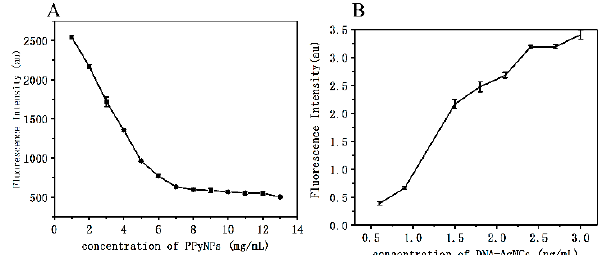
Figure 5. ( A ) The FI of C6G5C6-apt-AgNCs in the presence of various concentrations of PPyNPs (1, 2, 3, 4, 5, 6, 7, 8, 9, 10, 11, 12, and 13 mg / mL). ( B ) The FI of di ff erent concentrations of C6G5C6-apt-AgNCs at 634 nm in the presence of PPyNPs (8 mg / mL) and SEA (1 µ g / mL). When 8 mg / mL PPyNPs or more were added, the fluorescence remained basically unchanged.